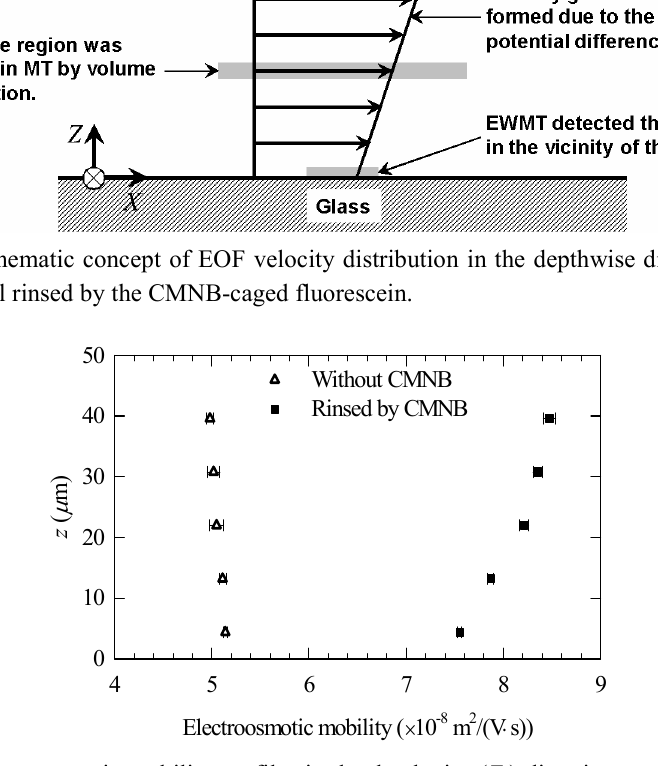
Figure 9. Electroosmotic mobility profiles in the depthwise ( Z -) direction at y = 50 µ m. z = 0 corresponds to the glass wall, while z = 50 µ m corresponds to the PDMS wall. The micro-PIV technique using the confocal scanner was applied to the glass-PDMS microchannel without and rinsed by the CMNB-caged fluorescein. An electric field of 37 V/cm was